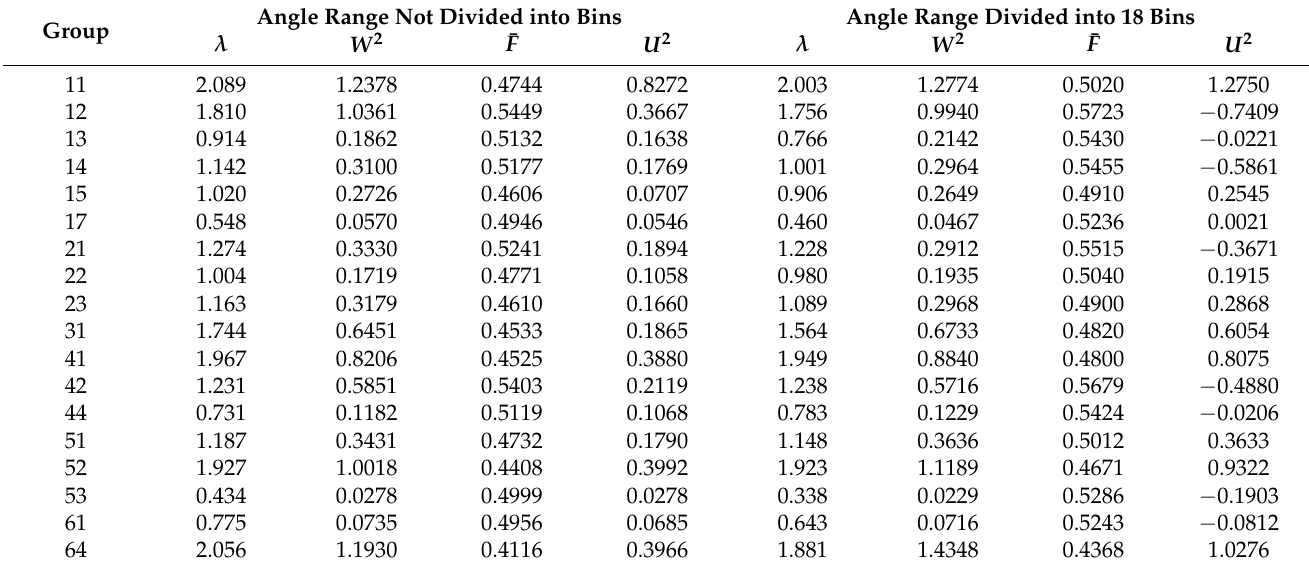
Table A2. Comparison of statistical tests calculated by dividing and not dividing the range of the analyzed angle η into bins, with he inclination taken directly from the NBG Catalog.